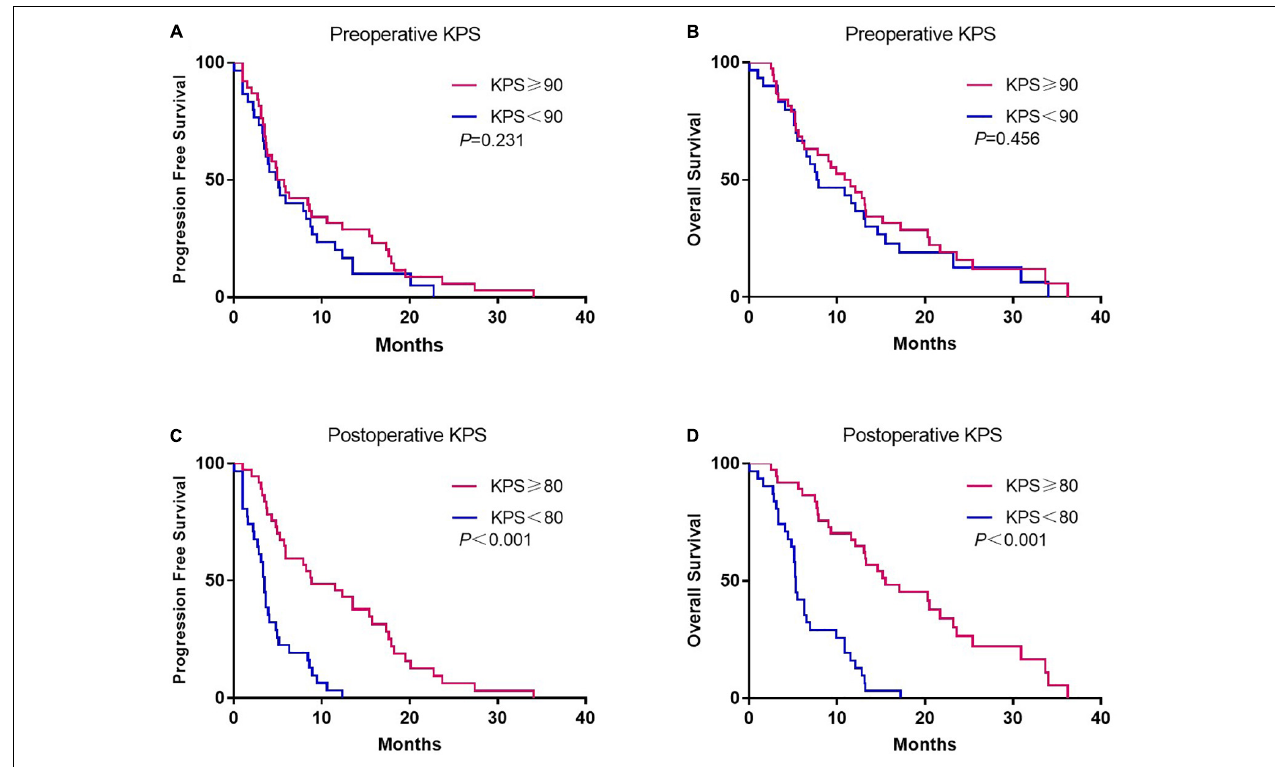
FIGURE 2 | Kaplan-Meier curves of progression-free survival and overall survival according to preoperative (A,B) and postoperative KPS (C,D) .